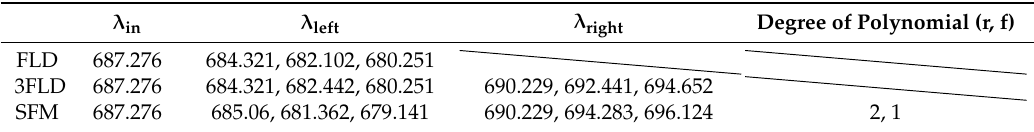
Table 4. Different parameters set of each fluorescence extraction algorithm for the O 2 -B absorption band. Degree of Polynomial(r, f) λ in λ left λ right